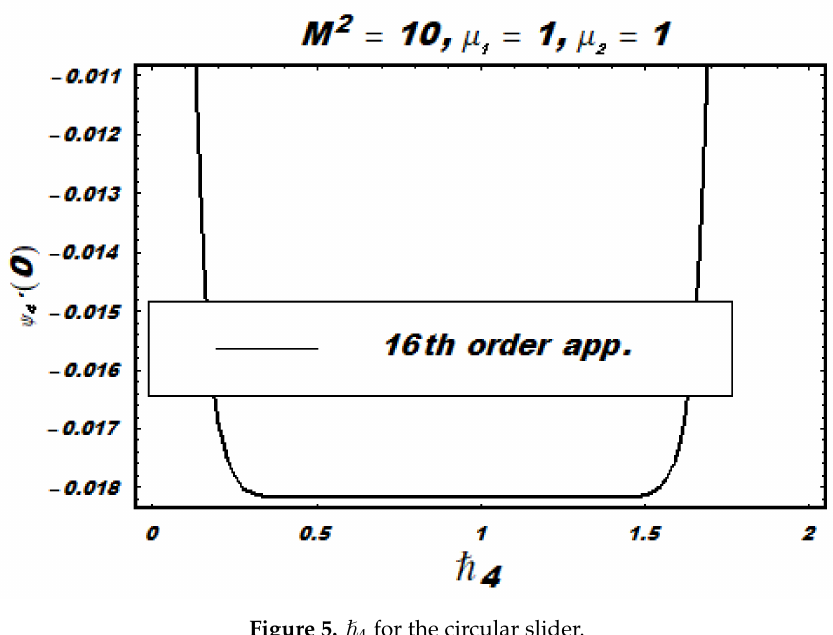
Figure 5. (cid:125) 4 for the circular slider.